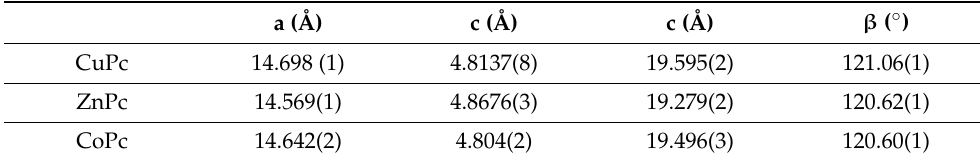
Figure 1. X-ray diffraction (XRD) patterns of Cu-, Zn- and Co-phthalocyanine. The red line is the Rietveld fit of the experimental data. Table 3. Lattice parameters of Cu-, Zn- and Co-phthalocyanine. Table 3. Lattice parameters of Cu-, Zn- and